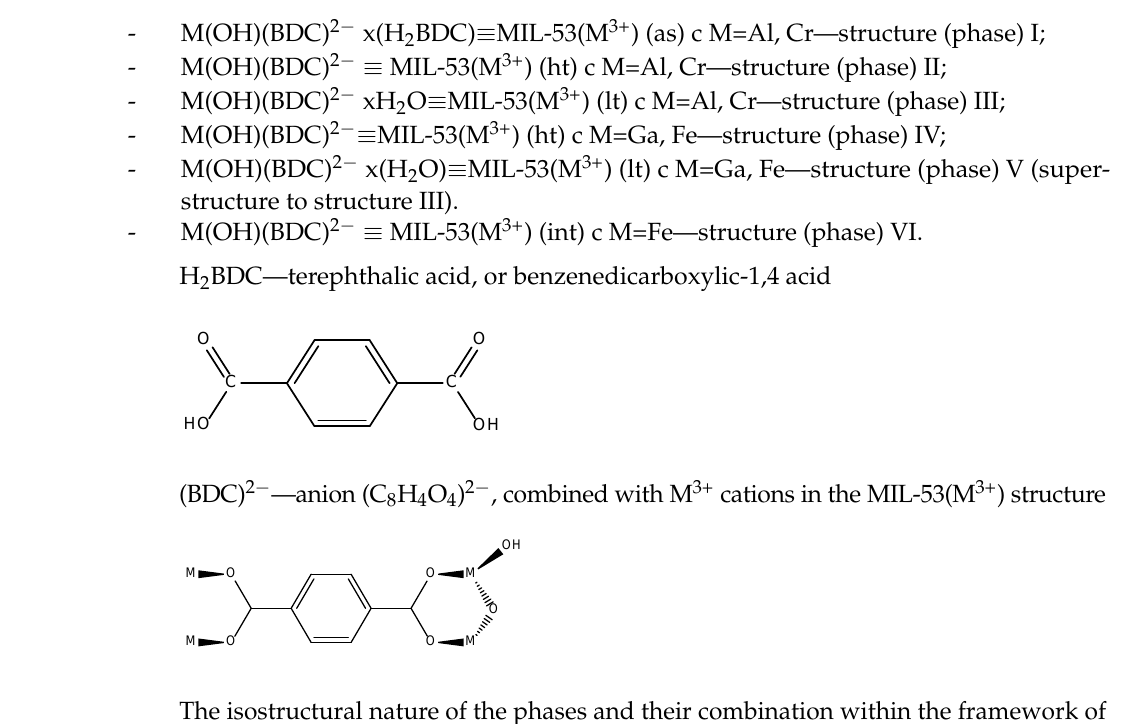
The isostructural nature of the phases and their combination within the framework of I-VI is confirmed by the similarity of the theoretical diffraction patterns (Figure 1, Figure 2,